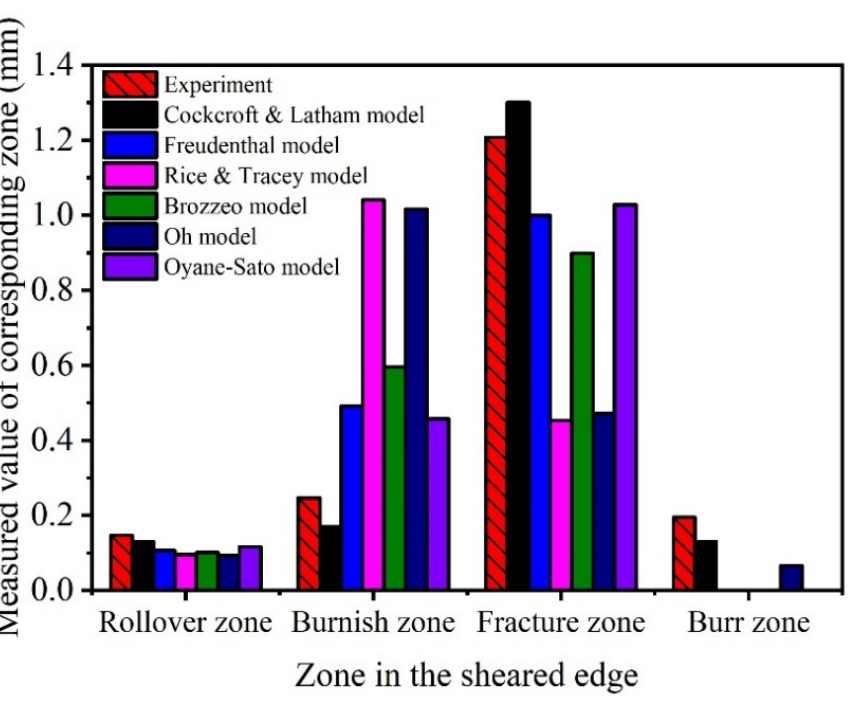
Figure 24. Depth of rollover zone, burnish zone, fracture zone, and burr zone measured from the experiment results and simulation results simulated with different ductile fracture criteria.